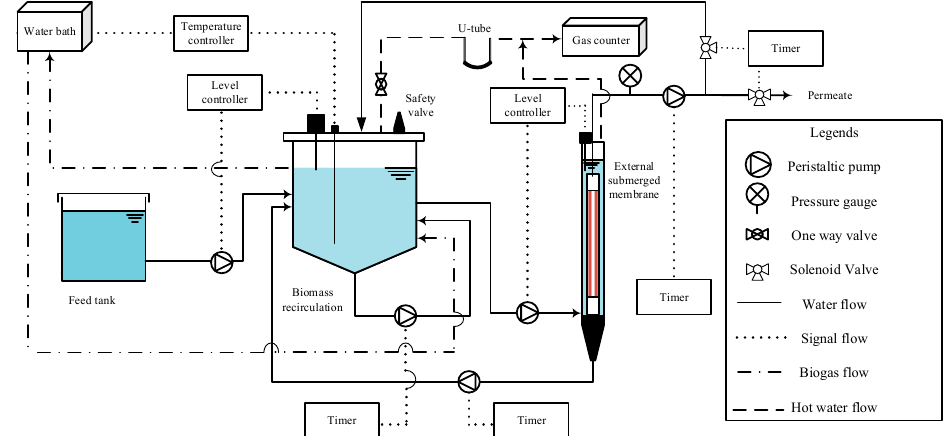
Figure 1. Schematic diagram of the -Thermophilic Anaerobic Membrane Bioreactor.